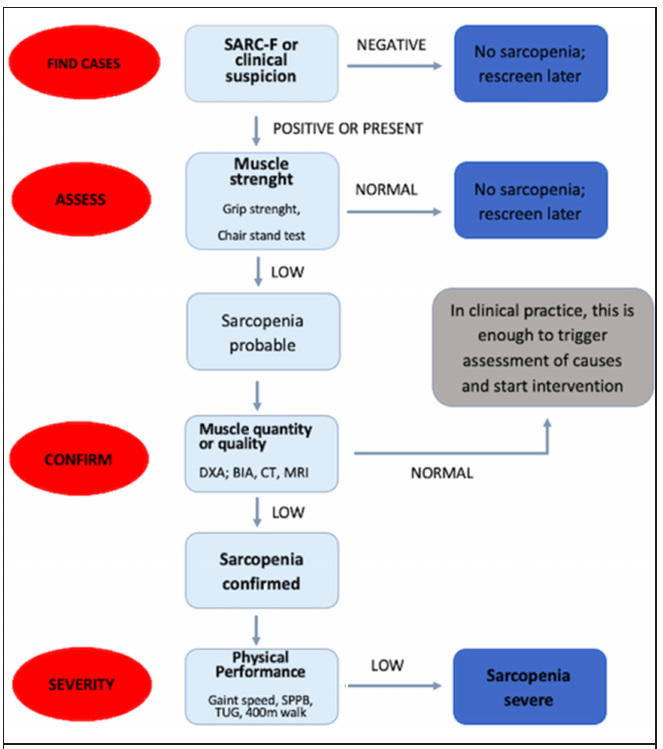
Figure 1. Sarcopenia: EWGSOP2 algorithm for case-finding, diagnosis, and quantifying severity in practice. BIA, bioelectrical impedance analysis; CT, computed tomography; DXA, dual-energy x-ray absorptiometry; MRI, magnetic resonance imaging.